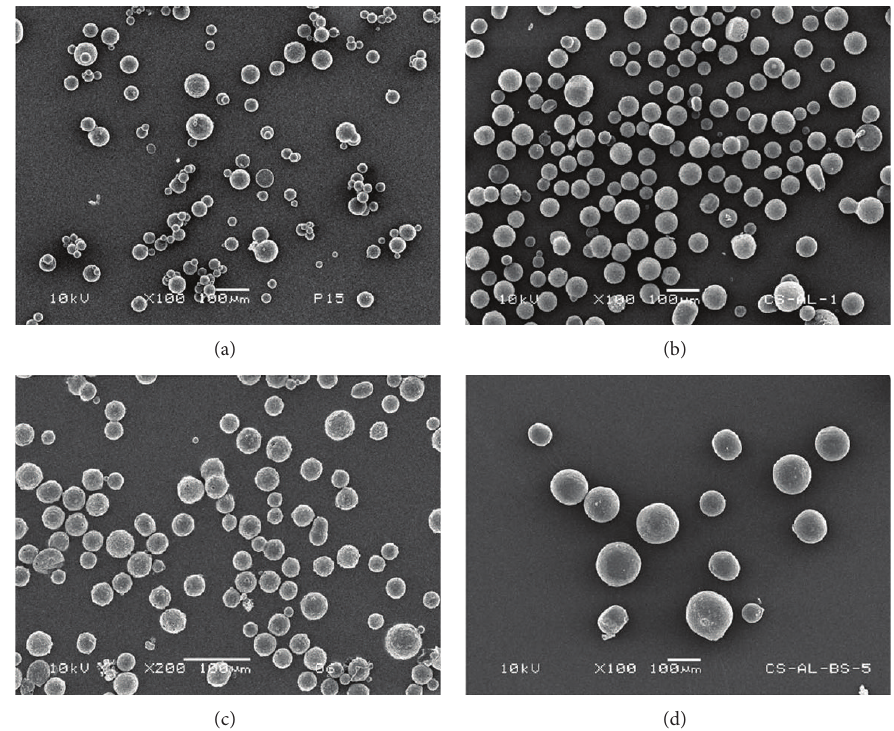
Figure 1: SEM images of drug-free microspheres of (a) 15kDa chitosan, (b) 100kDa chitosan, (c) potato starch, and (d) alginate. All bars = 100 𝜇 m.